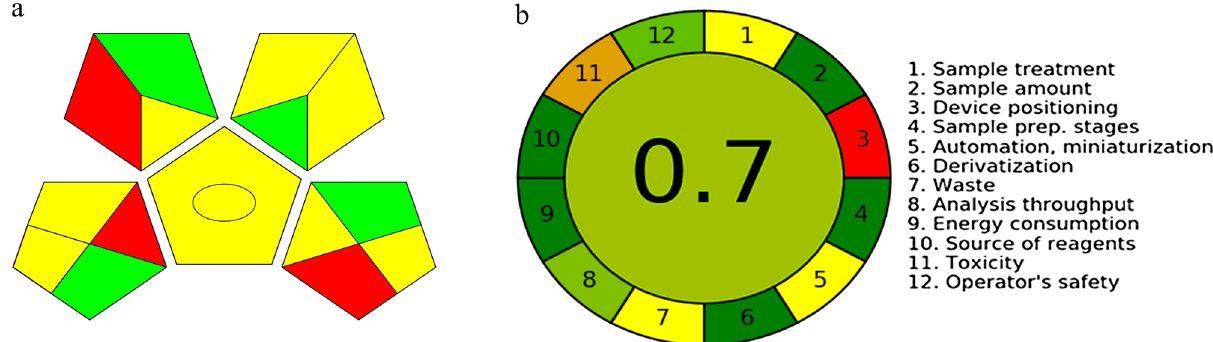
Figure 3. ( a ) GAPI—green analytical procedure index ( b ) AGREE – Analytical GREEnness Calculator assessments of our proposed